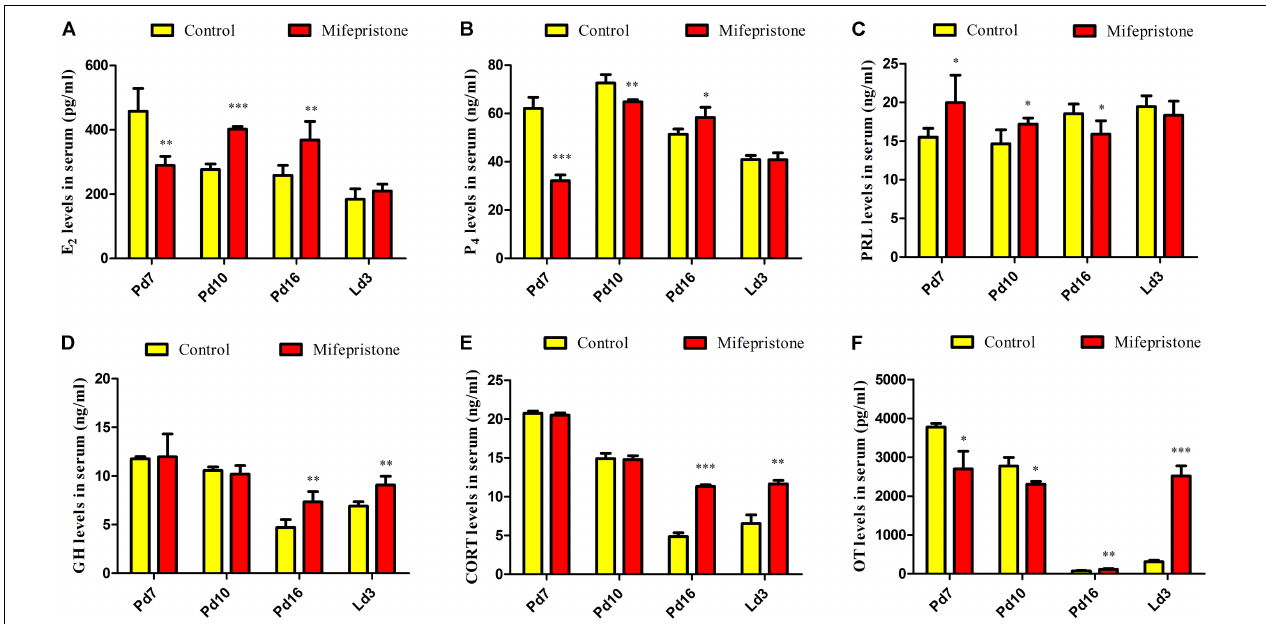
FIGURE 5 | Effects of mifepristone treatment on pregnancy day 4 (Pd4) on serum hormones levels of mice on Pd7, Pd10, Pd16, and lactation day 3 (Ld3). (A) Serum E